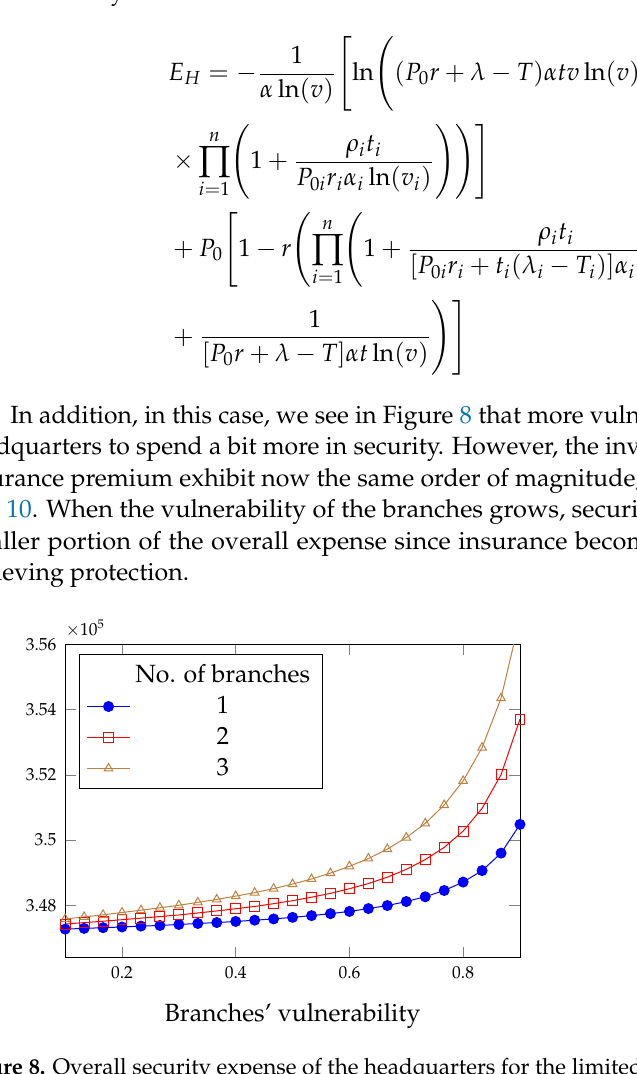
Figure 8. Overall security expense of the headquarters for the limited liability case.